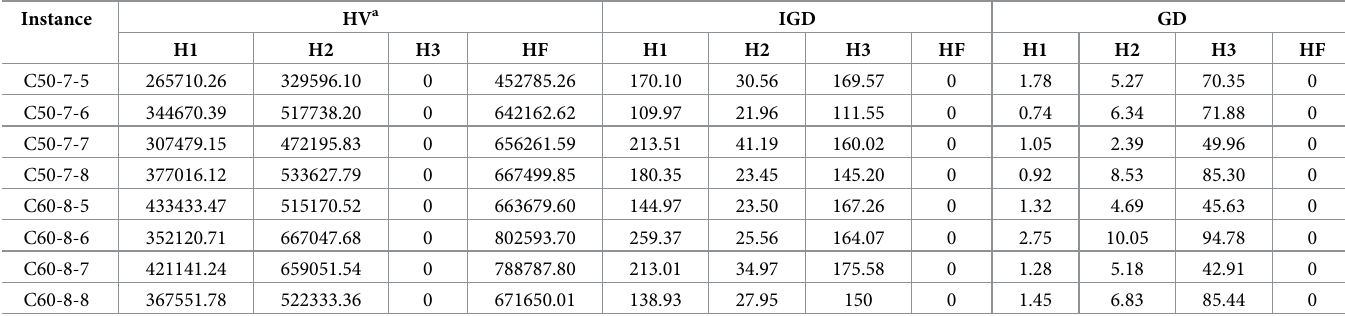
Table 8. Performance indicators of four variants of fleet